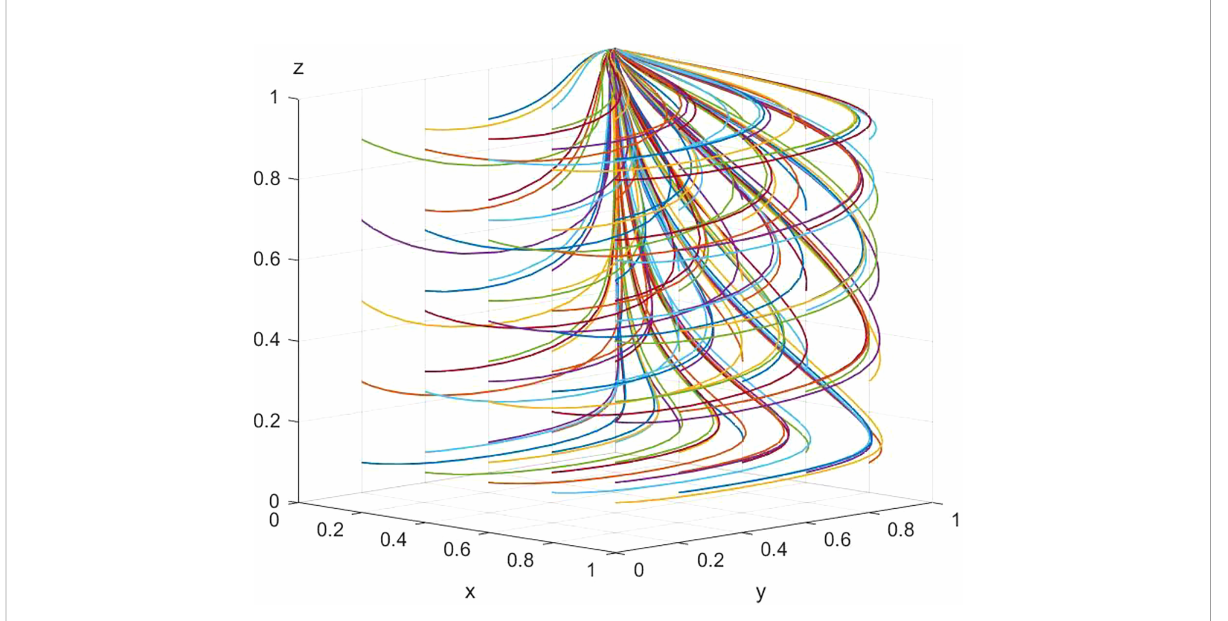
FIGURE 3 Mature stage evolutionary